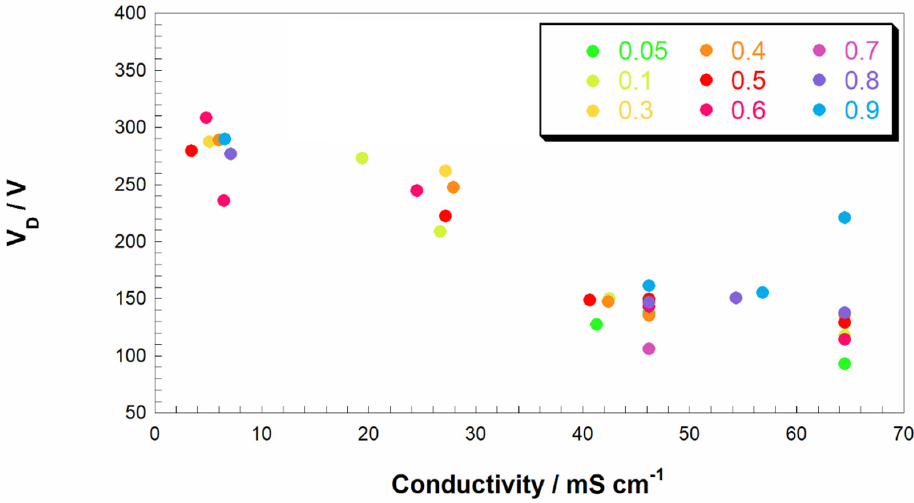
Figure 5. Discharge voltage, V D , as a function of the conductivity of the solution. Different colors refer to different ratios of cathode-to-anode immersed area. Electrolyte was the same for all experiments.